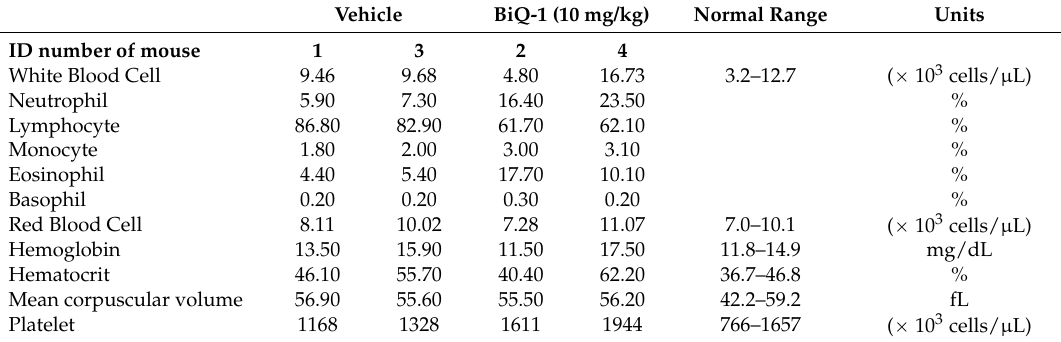
Table 2. Complete Blood Count findings in mice treated with